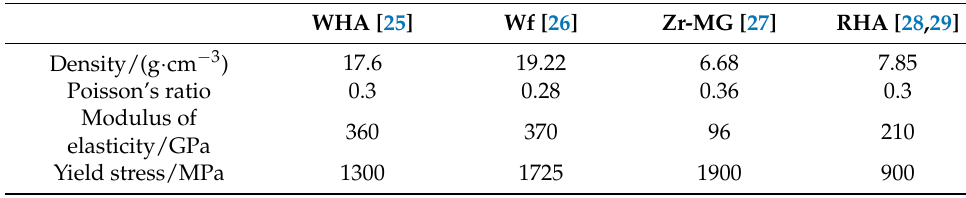
Table 1. Main mechanical properties of all materials used in the